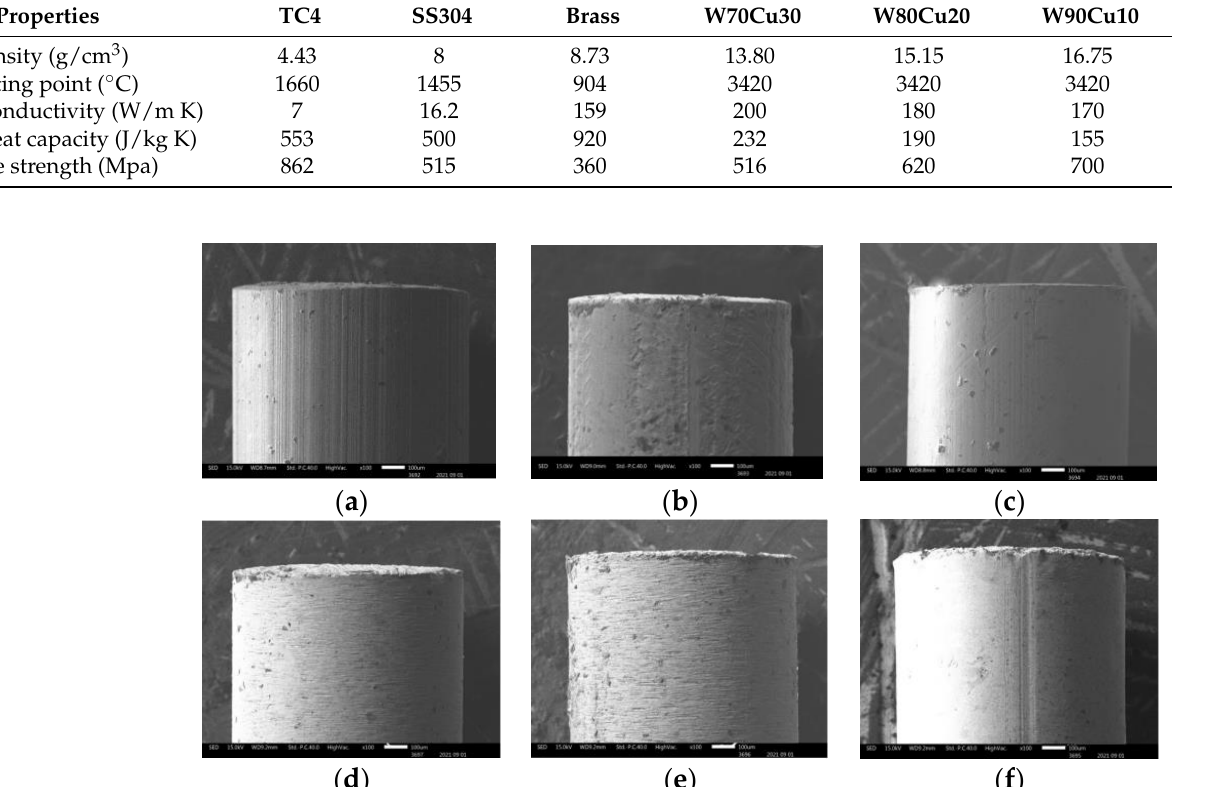
( f ) Figure 4. Energy-dispersive X-ray spectroscopy (EDX) spectrum analysis of six electrodes before ECDM: ( a ) SS304; ( b ) TC4; ( c ) brass; ( d ) W90Cu10; ( e ) W80Cu20; ( f ) W70Cu30. Table 1. Properties of the electrode materials. Properties